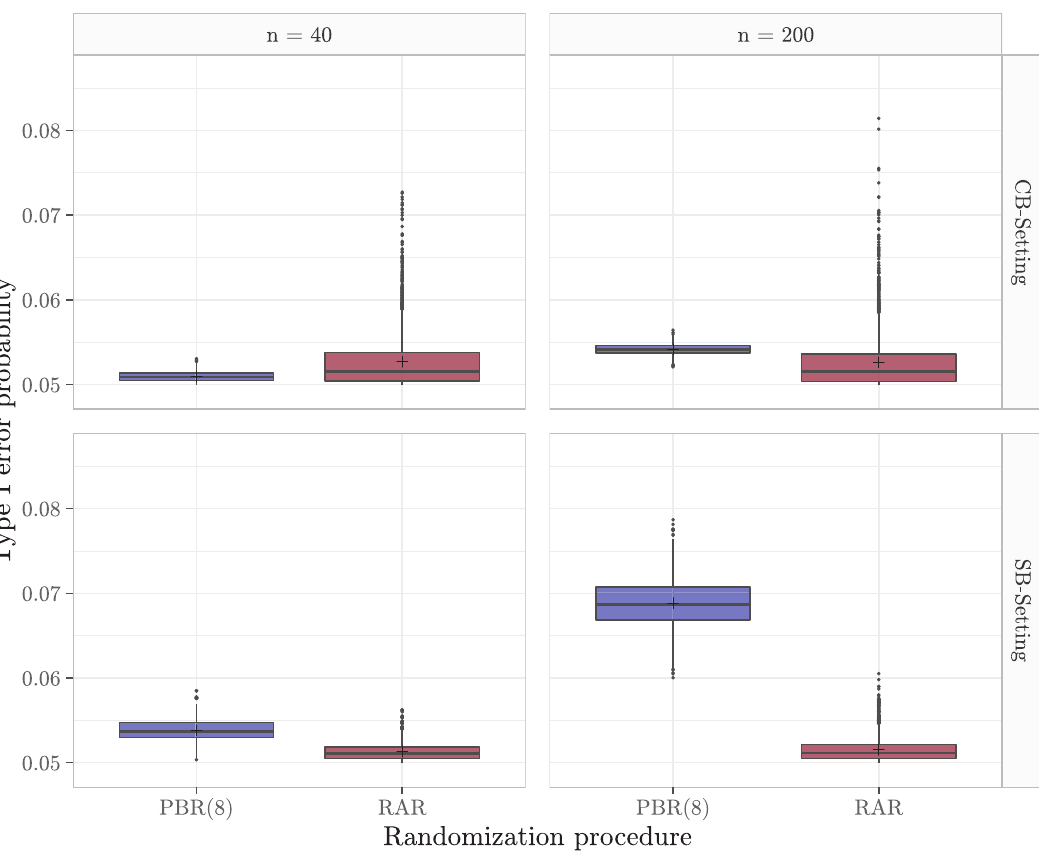
PLOS ONE | https://doi.org/10.1371/journal.pone.0217946 June 3,